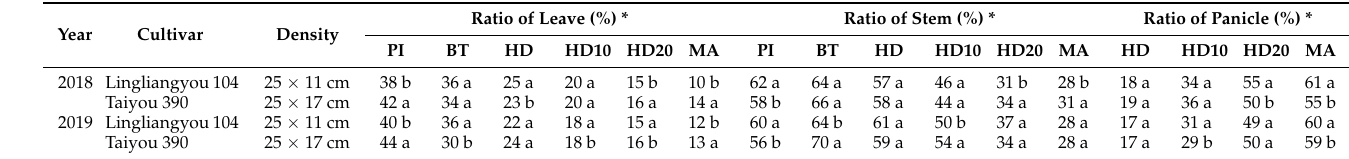
Table 5. Dry weight ratio of leaves, stem, and panicle to total biomass at different growth stages of two growth-duration rice cultivars under two planting densities in 2018 and 2019. Cultivar Density